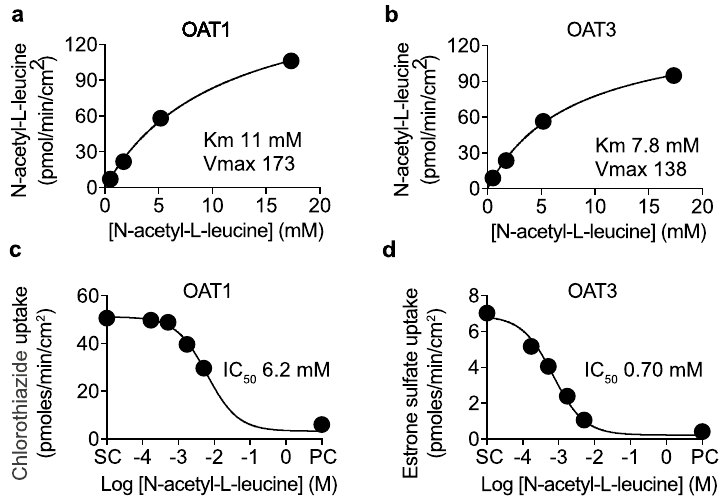
Figure 3. N -acetyl-l-leucine is transported by organic anion transporters (OAT). Concentration–response curves for the uptake of N -acetyl-l-leucine by ( a ) OAT1 and ( b ) OAT3. Concentration-inhibition curves for the inhibition of uptake of known substrates ( c ) chlorothiazide for OAT1 (3 µM) and ( d ) estrone-3-sulfate for OAT3 (2 µM). DMSO (0.5%) was the solvent control (SC) and the known inhibitor diclofenac (100 µM) was the positive control (PC). Data were fit to either the Michalis-Menten equation for uptake or the Hill equation for inhibition using the solvent control to define the top and the positive control inhibitor to define the bottom. Symbols represent the mean ± SEM, n = 3. When the error bars are smaller than the symbol, they are not